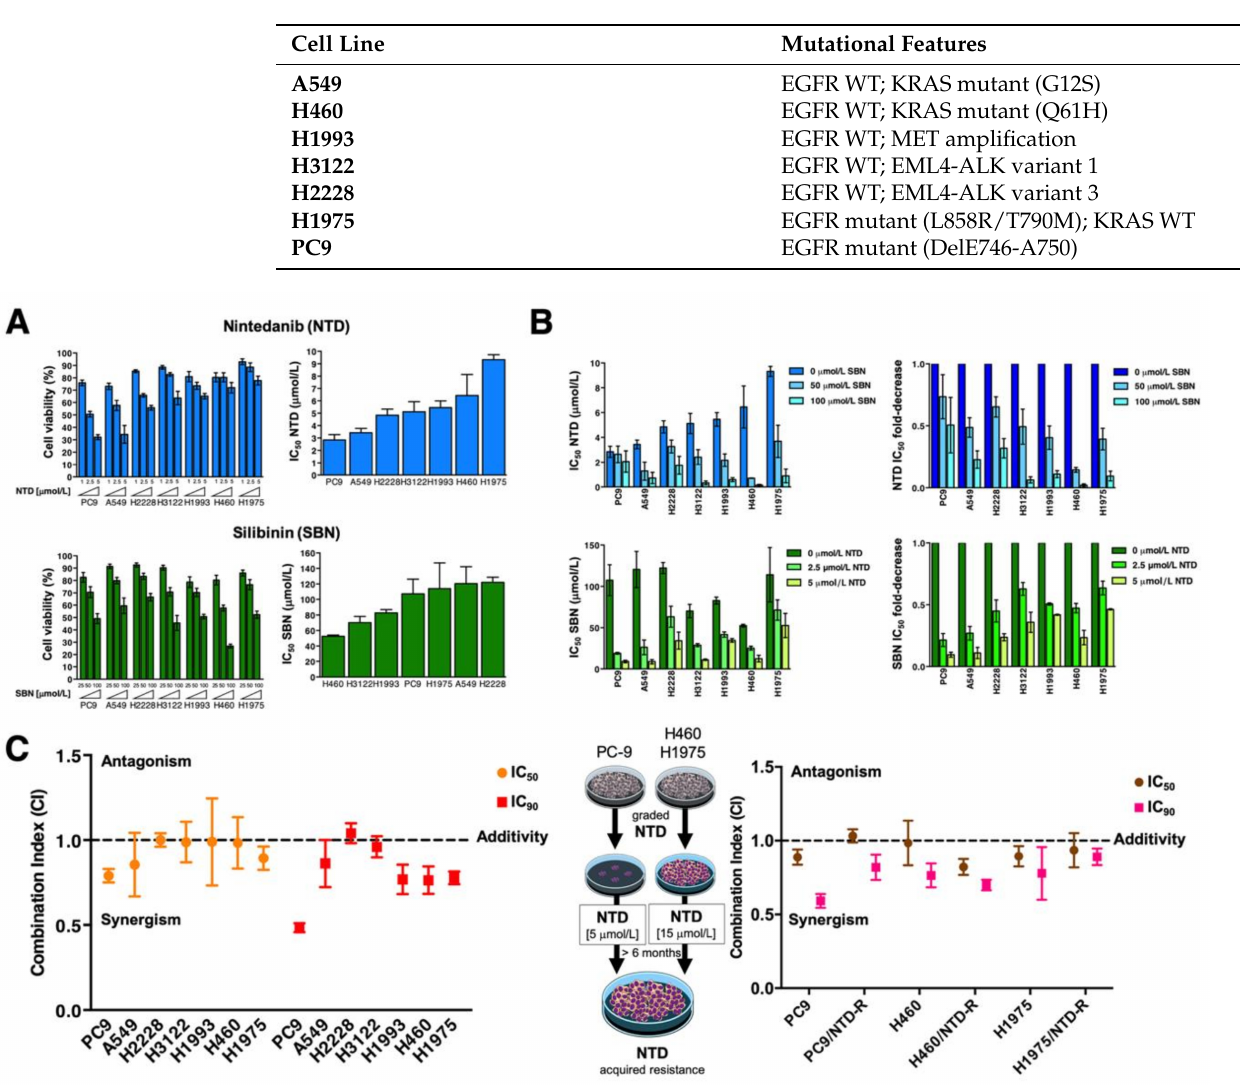
Table 1. NSCLC cell lines characteristics.